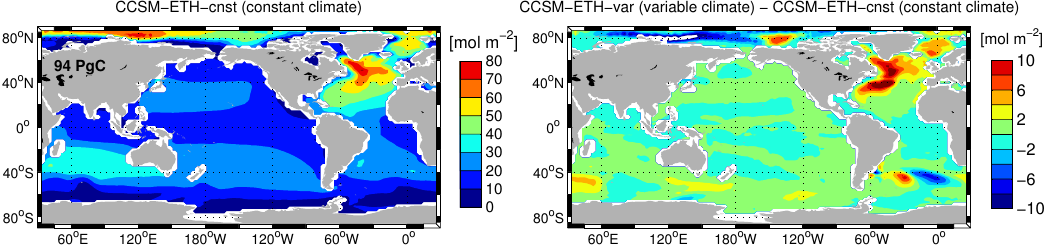
Fig. 5. Comparison of anthropogenic CO 2 simulated in the CCSM-ETH model under constant climate (CCSM-ETH-cnst) and with time- varying climate (CCSM-ETH-var). Left: Column inventory of anthropogenic CO 2 in 1994 simulated in the constant-climate simulation. Right: Difference in column inventory in 1994 between variable-climate and constant-climate simulations. (Note the different scales.) The total inventory in the constant-climate case was 94PgC, while that in the variable simulation was 95PgC.